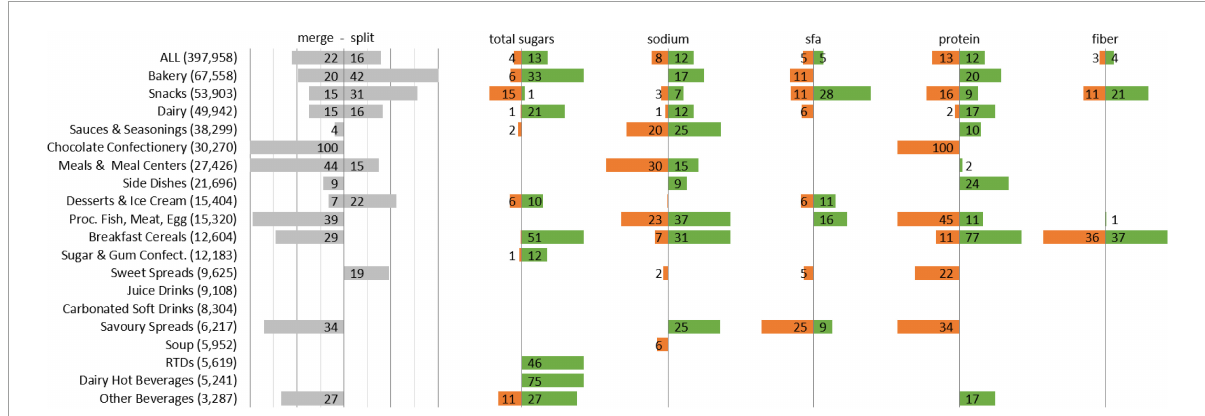
FIGURE1 Percentage of products belonging to a nutritionally homogeneous subcategory in 2018–2020 that either merged two or more subcategories of 2016–2018 or that split from a larger category. For each nutrient, percentage of products belonging to a subcategory for which the nutrient threshold improved by at least 5% (green) or was relaxed by at least 5% (orange) between 2016–2018 and 2018–2020.